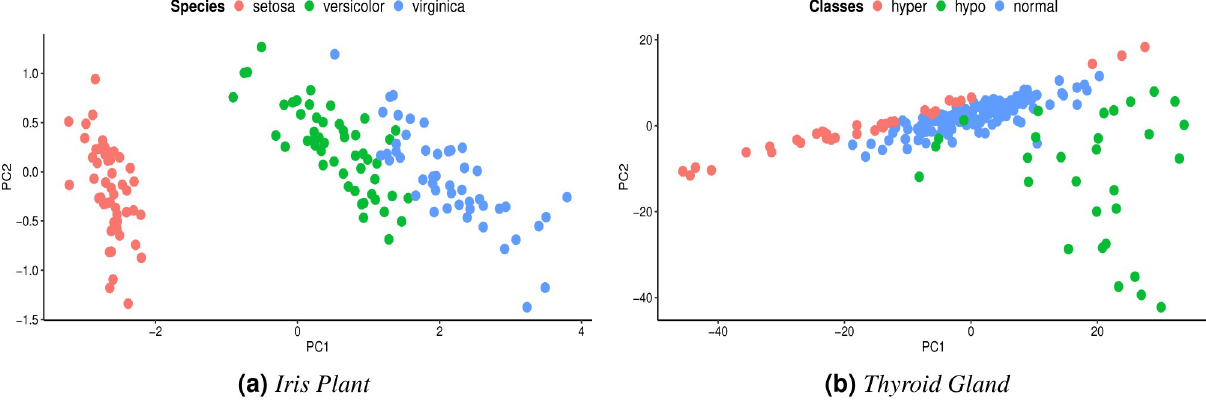
Fig 9. Principal component analysis applied to both datasets. ( a ) Iris Plant . ( b ) Thyroid Gland .